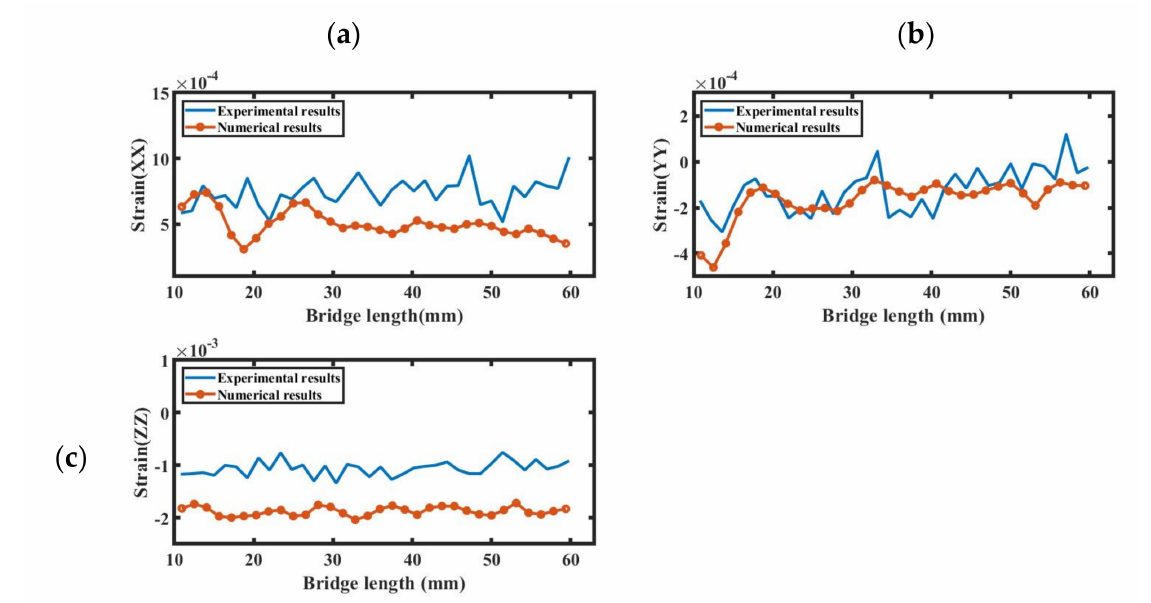
Figure 9. The ( a – c ) represents the comparison of experimental and simulation residual strain at z = 9.536 in the x, y, and z-directions respectively.